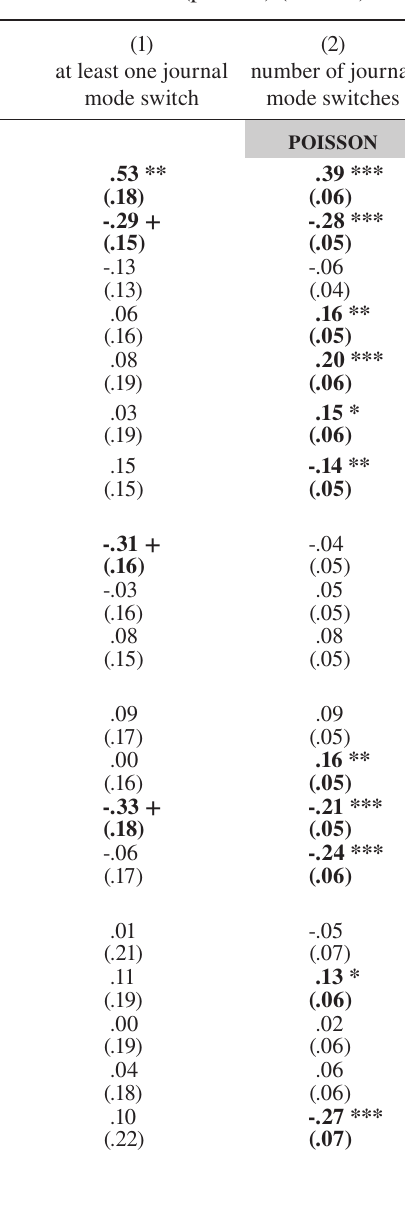
Regression coefficients for models of at least one journal mode switch (logistic) and number of journal mode switches (poisson)